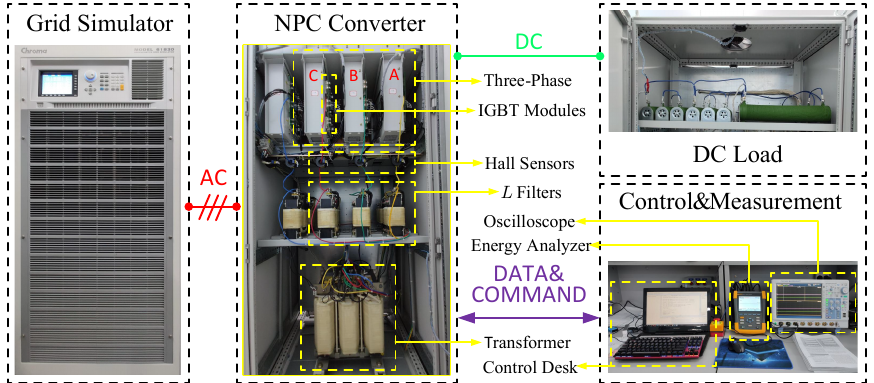
Figure 7. Prototype of NPC converter